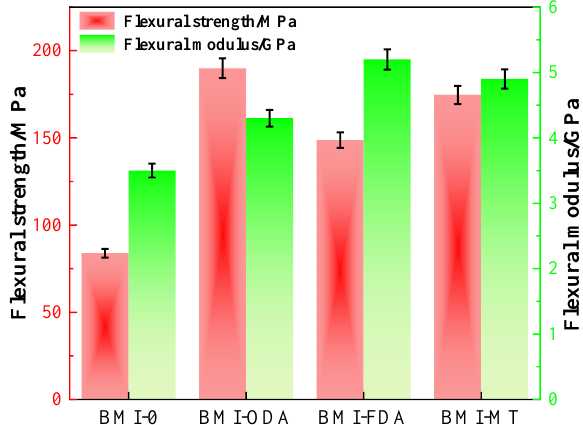
Figure 4. Mechanical properties of columns of BMI-NH 2 .